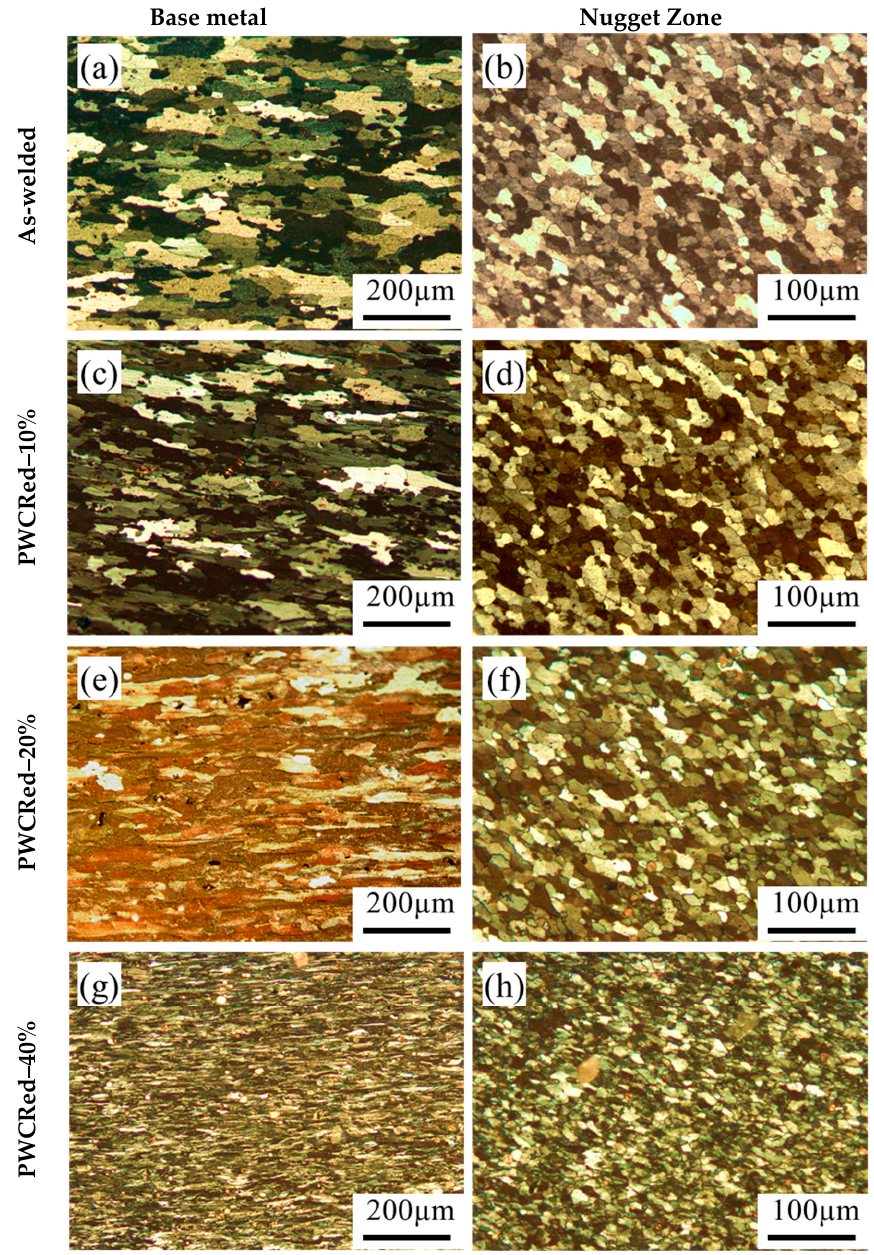
Figure 4. Microstructures of the base metal and nugget zone before and after the post-weld cold-rolled process. ( a , b ) as-welded, ( c , d ) PWCRed–10%, ( e , f ) PWCRed–20%, ( g , h ) PWCRed–40%.